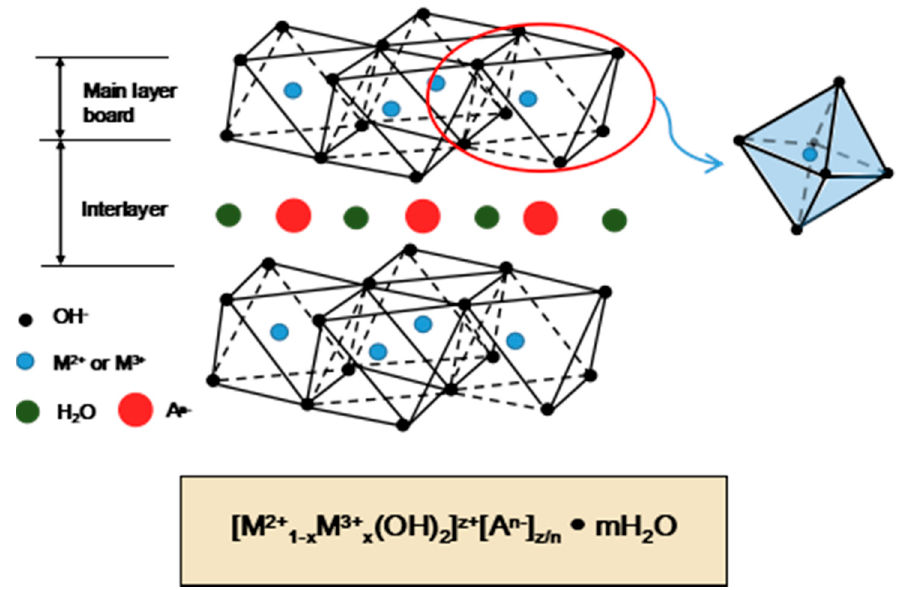
Figure 6. The basic structure of hydrotalcite.